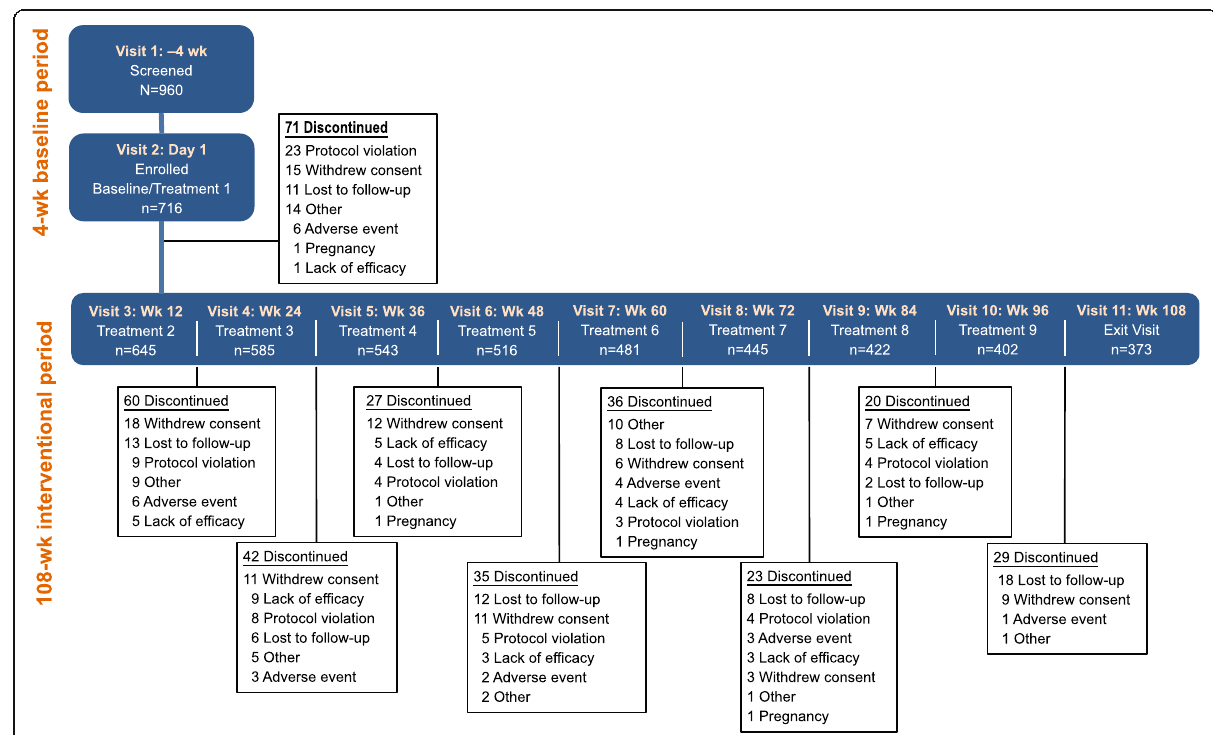
Fig. 2 Patients who completed/withdrew from the study, including a summary of reasons for study